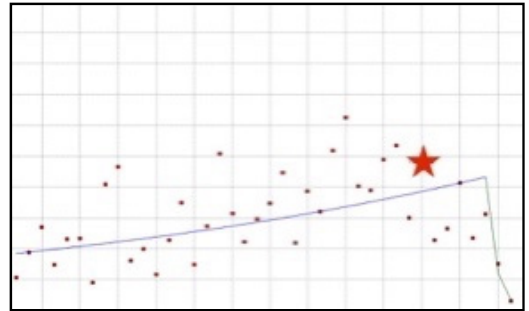
Figure 3. A schematic graph of the frequency of use of boron in the respective quarters in the period from the first quarter of 2012 to the fourth quarter of 2021. The star denotes the moment of publication of the resolution concerning the ingredient. The height of placement of the symbol reflects the level of use of the ingredient. Boron (Figure A16).